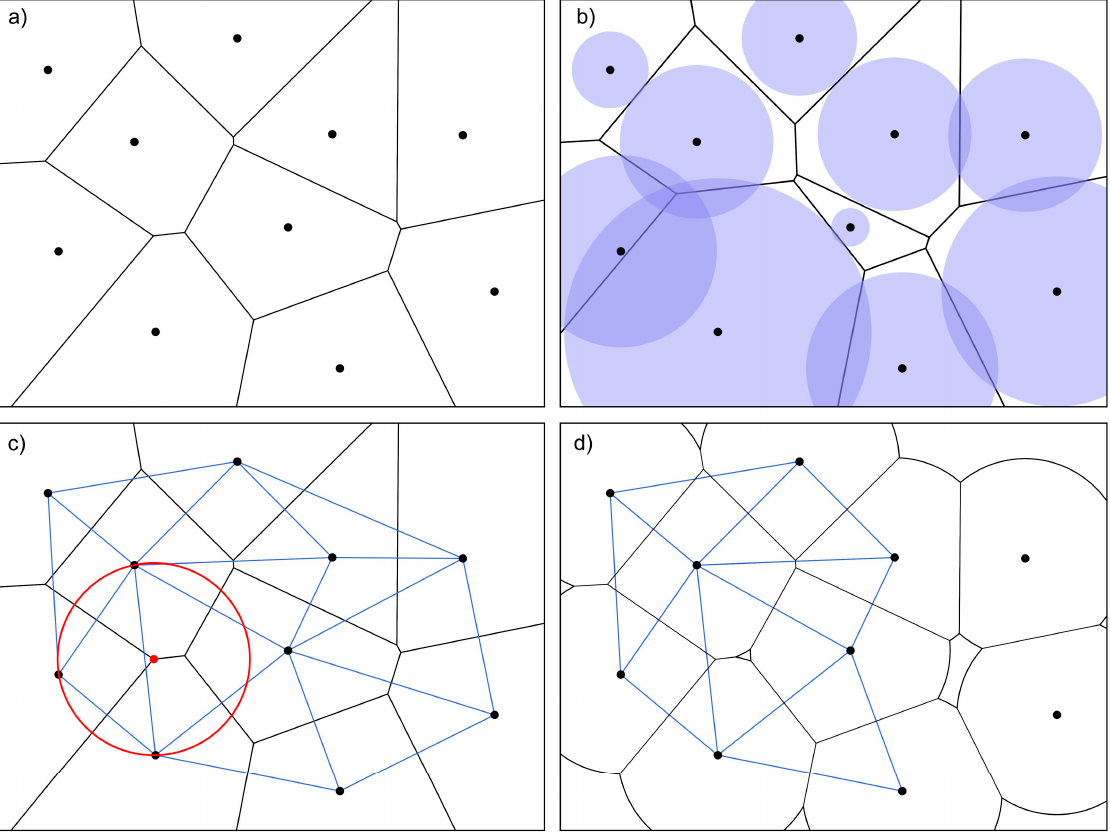
Figure 4. Key computational geometry tools presented in 2D. ( a ) The Voronoi diagram of the point set. Voronoi cells contain all space nearest to its sample; ( b ) a Power diagram , with weights denoted by the radius of the blue circle surrounding each point. Power cells contain all space, in which the distance subtracted by its cell weight (i.e., the Power distance ), is less than competing cells. The cell edges of competing samples are drawn at the distance where the outer circle boundaries intersect. If all weights are equal it would result in the same diagram as in ( a ); ( c ) The Delaunay triangulation (blue), which is the dual graph of the Voronoi diagram (black). An example of an empty circumcircle (red), centered at a Voronoi vertex (red), showing that its triangulation is Delaunay; ( d ) A restricted Voronoi diagram (black), with a uniform weight determining the maximum extent of the cells. The resulting Delaunay triangulation (blue) is made for the trios of adjoining cells. A lack of cell adjacencies results in several points becoming excluded from the triangulation. Visualization adapted from Devert [64] and Royer [65] with the Scipy Spatial [66] and Matplotlib [67] libraries for Python.